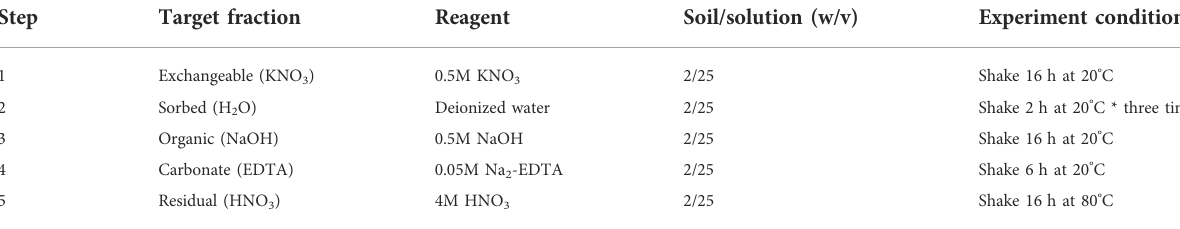
TABLE 1 Summary of the sequential extraction steps and procedures of Cd fractionation.